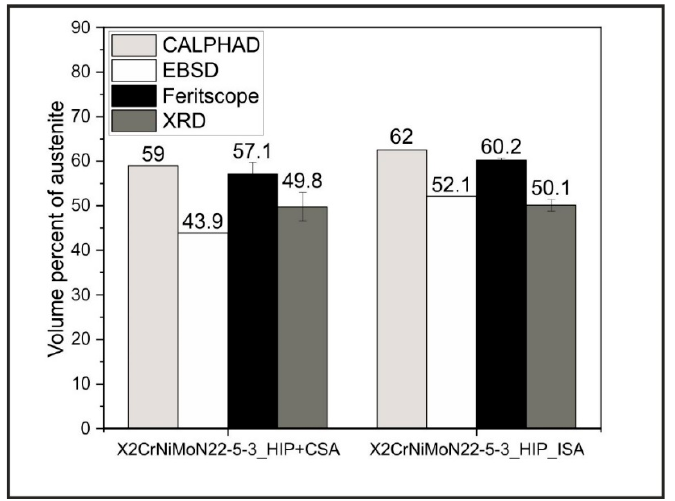
Figure 3. Overview of the austenite contents determined by CALPHAD, EBSD, Feritscope ® , and XRD for the two considered conditions: X2CrNiMoN22-5-3_HIP+CSA (solution annealing at 0.1 MPa and 1075 °C) and X2CrNiMoN22-5-3_HIP+ISA (solution annealing at 170 MPa and 1075 °C).